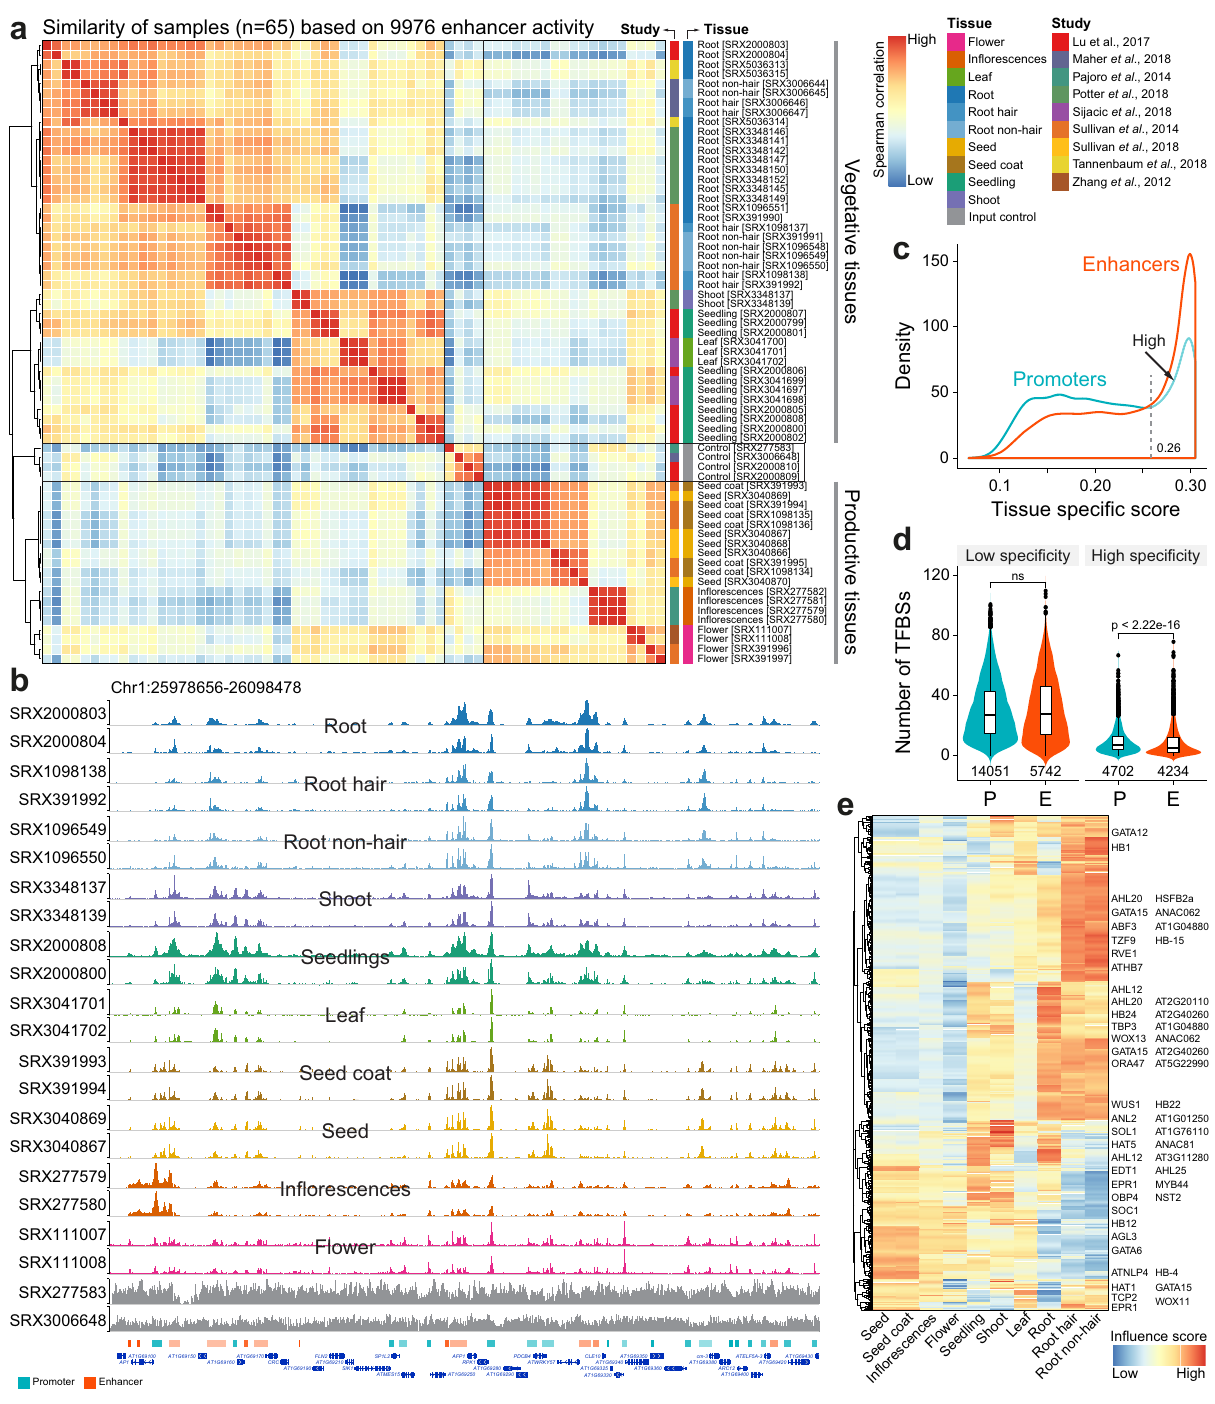
Fig. 4 Prediction of tissue-speci fi c regulatory elements promoters and enhancers. a Sample similarity based on enhancer activity. Open chromatin samples (with IDs labeled in square brackets) were collected from nine different studies. The input DNA samples (in grey; n = 4) are used for control. Note that samples of productive tissues are well separated from those of vegetative tissues. b Genome browser view of selected samples (colored as a ). Annotated promoters and enhancers are provided at the bottom of tracks. Genome browser view of all samples can be found in Supplementary Fig. 11. c Distribution of tissue-speci fi c scores (Jensen-Shannon diversity index) of promoters and enhancers. Highly speci fi c regulatory elements are de fi ned based on a cutoff (0.26) indicated by the dash line. d Enrichment of TF binding sites in accessible regions with low or high speci fi city. P, promoter; E, enhancer; ns, no signi fi cance. Statistical signi fi cance of difference was calculated by the two-sided Mann – Whitney U test. Boxplot showing the median (horizontal line), second to third quartiles (box), and Tukey-style whiskers (beyond the box). e Heatmap showing normalized in fl uence of motif-annotated fi lters on classi fi cation of promoters in different tissues. Filters matched to known motifs are labeled. Source data are provided as a Source Data fi le.